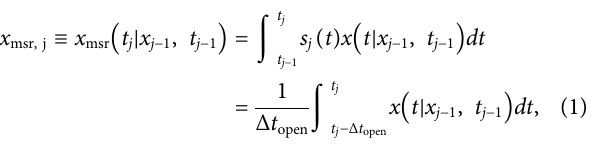
Frontiers in Physics |